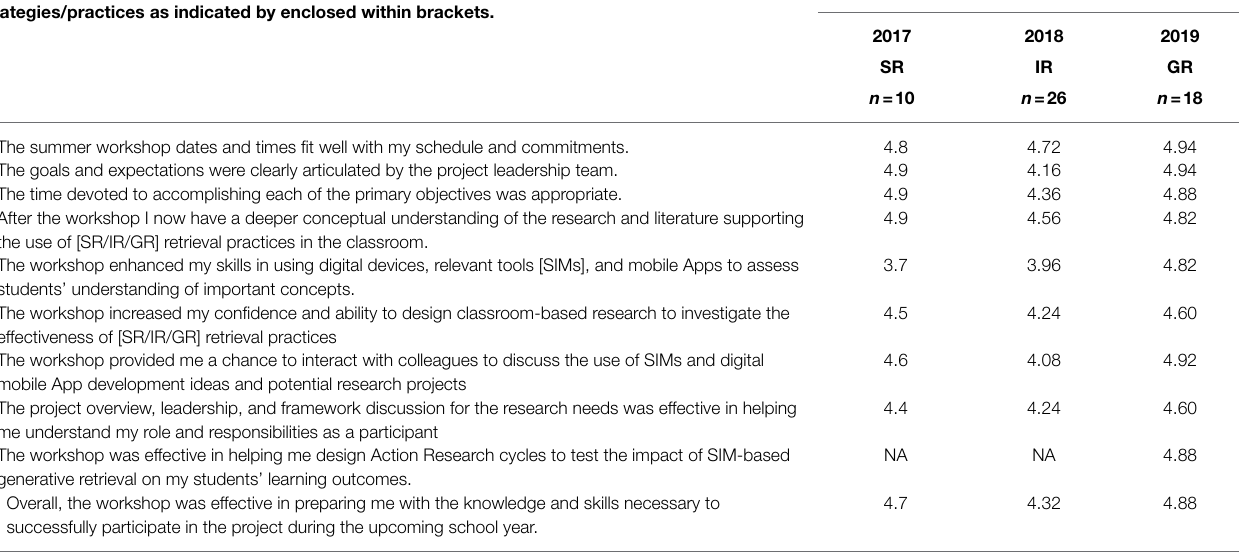
TABLE 2 | Likert-scaled questions and answers from summer